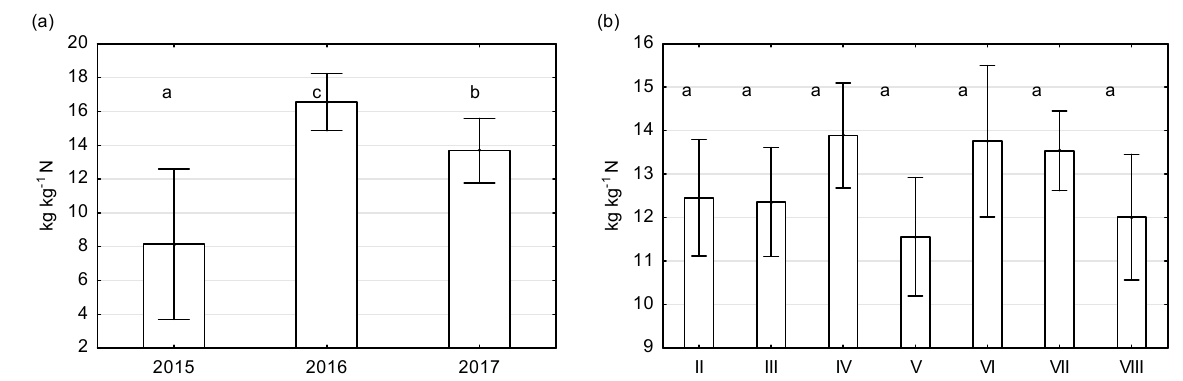
Figure 1. Agronomic efficiency (AE) of fertilizing maize depending on a study year ( a ) and applied fertilization ( b ) — mean ± SE; data marked with same letters do not differ significantly at p < 0.05; figure ( a ) years of experiment (2015, 2016 and 2017), figure ( b ) number of object (II – VIII) — see Table 1. The highest PE (59.04 kg kg − 1 N) was determined in the first year of the experiment (Figure 2a), which had less rainfall than the 1981 – 2020 average, and the grain yields were smaller than the ones obtained in the entire experimental period. The lowest PE (27.19 kg kg − 1 N) was obtained in the second year of the study, which was characterized by higher rainfall than the long-term average, and the grain yield harvested was the highest in the whole experiment. Depending on the tested fertilization, PE varied from 28.38 to 68.27 kg kg − 1 N (Figure 2b). It was the lowest in the object fertilized prior to sowing with UAN + P(Starter) and top-dressed with UAN + Mg. The highest value of this parameter was achieved in the maize grown on the plots fertilized with UAN before sowing and with urea in a top-dressing application.